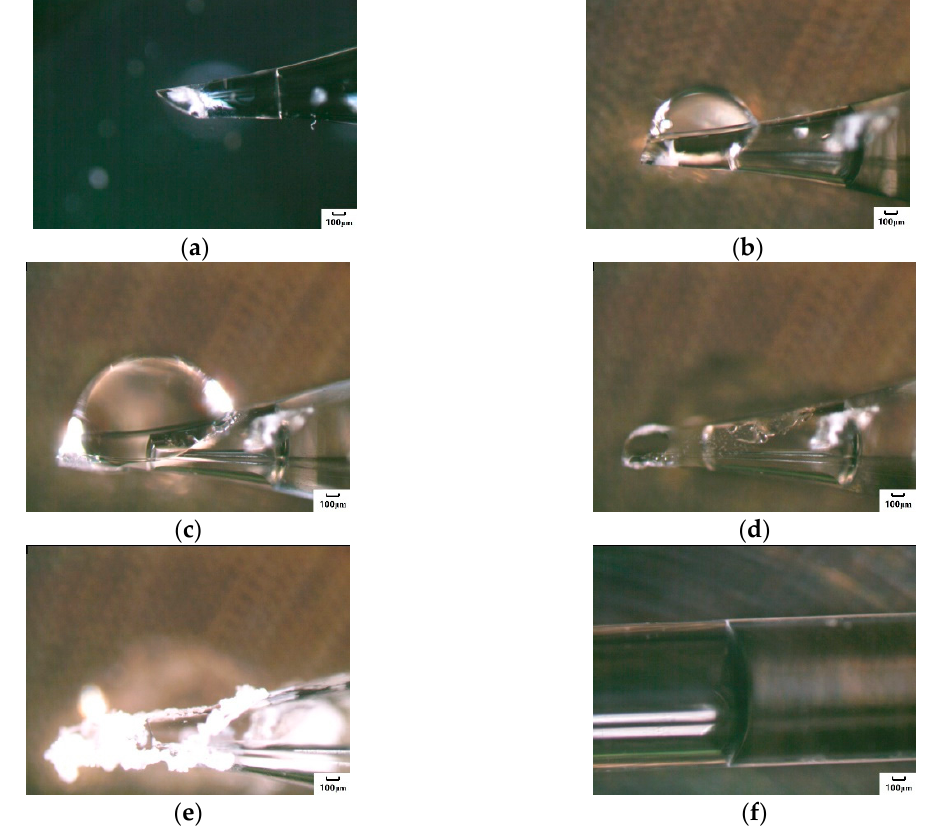
Figure 6. Crystallization process of the Na 2 SO 4 solution in the capillary tube with a large pore diameter. ( a ) Crystals appeared on the inner wall of tube. ( b ) Bubbles appeared. ( c ) Bubbles swelled. ( d ) New bubbles reappeared after previous bubbles collapsed. ( e ) Crystals dried up. ( f ) Solution was stable inside the capillary.